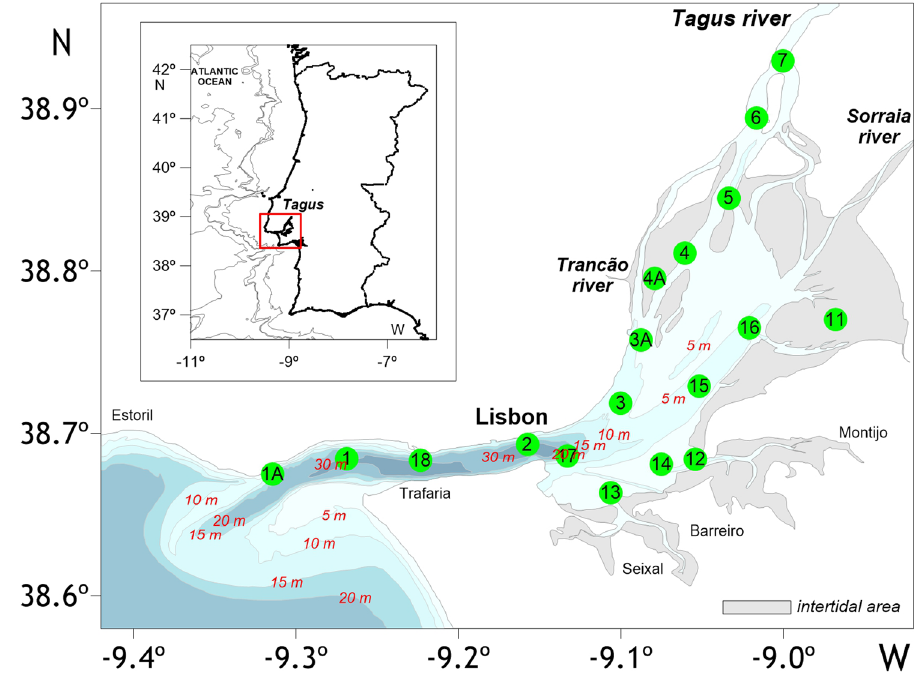
Figure 1. Map of Tagus estuary with the location of the sampling stations. Figure generated using the software Surfer Version 12.8.1009 (http://www.goldensoftware.com/products/surfer), a surface mapping system from Golden Software, LLC. Coastline and bathymetry were created based on Google “Map data: Google, Earth” (https://www.google.pt/maps/) and on data SIO, NOAA, U.S. Navy, NGA, GEBCO version 20141103 (http://